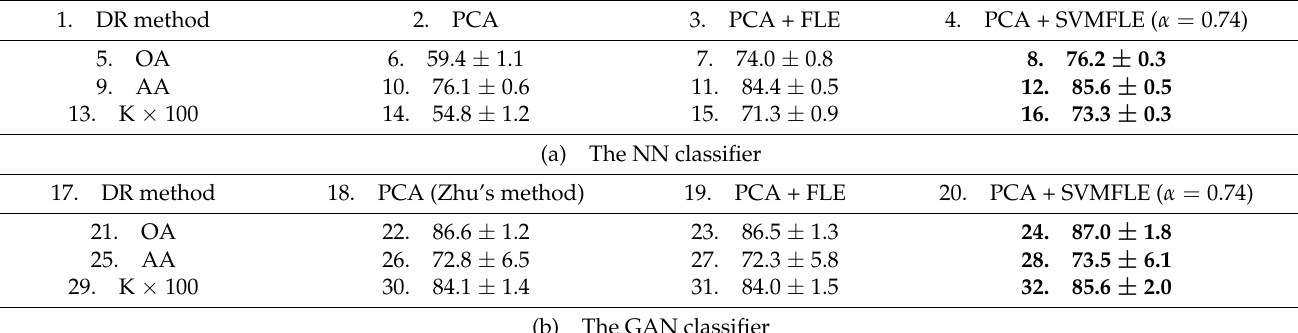
Table 8. The classification results on dataset